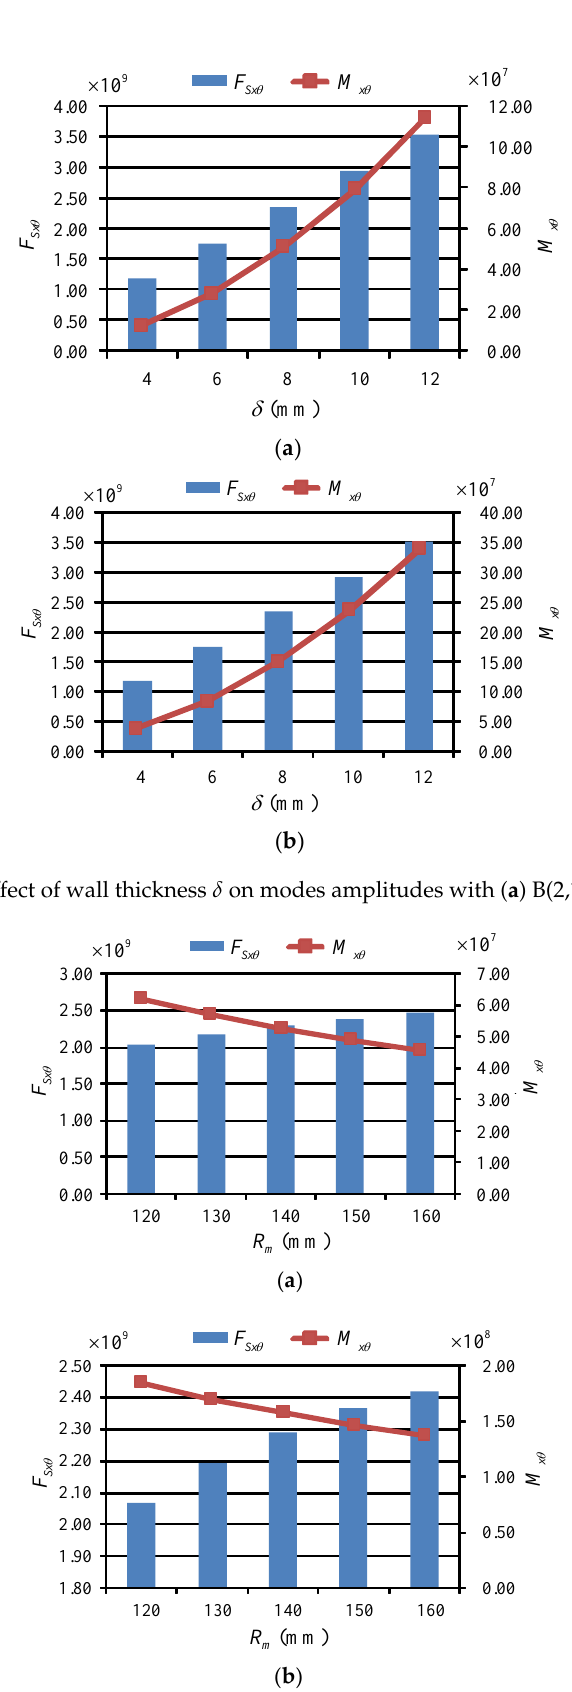
Figure 9. Effect of middle surface radius R m on modes amplitudes with ( a ) B(2,1); ( b ) B(4,2).